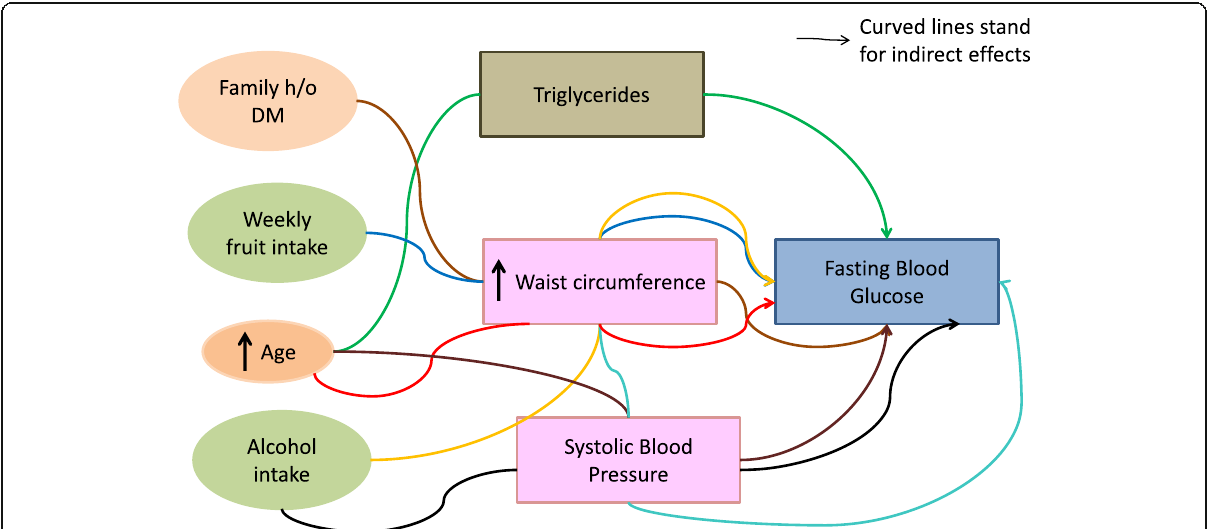
Fig. 2 Indirect effects of risk factors for diabetes in the STEPS survey in 2015 in Punjab, India among adults aged 18 – 69 years. Footnote: ellipse indicates latent, unobservable constructs; box indicates observed variable; curved line with one arrowhead denotes indirect